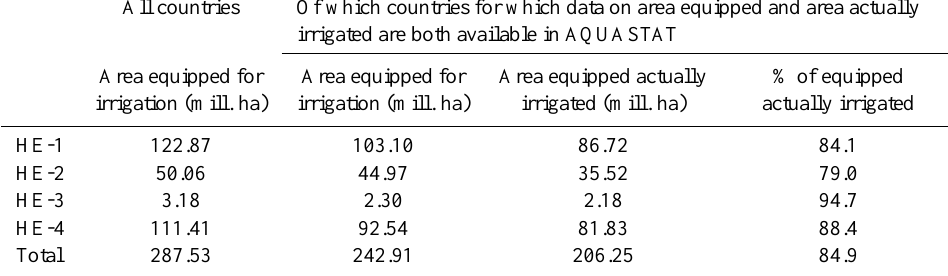
Source: FAOSTAT and AQUASTAT. Table A9. Water dimension – irrigation utilization intensity